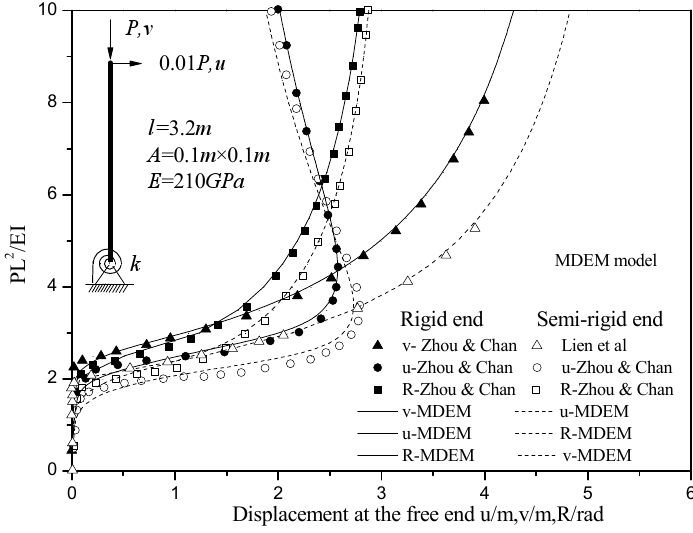
Figure 6. Load-displacement curves at the free end of the column.